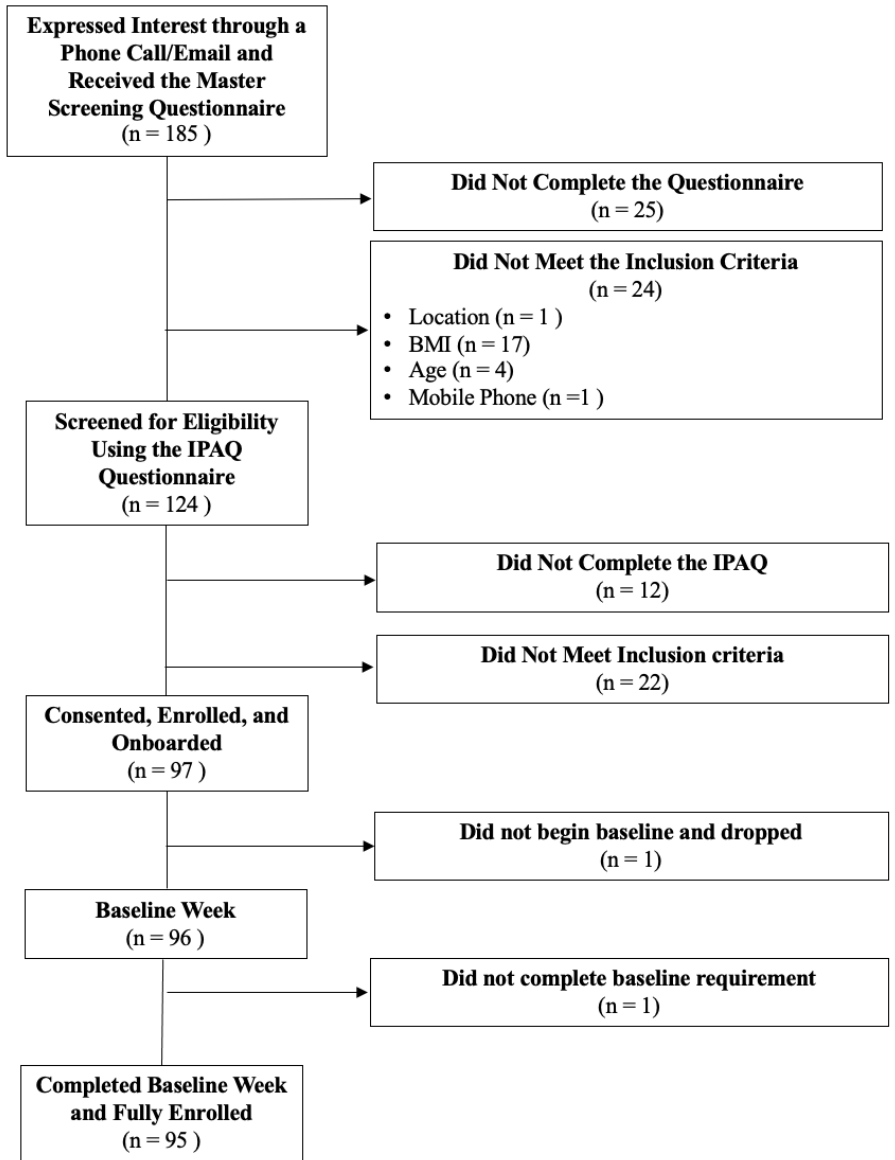
Figure 3. HeartSteps II consort